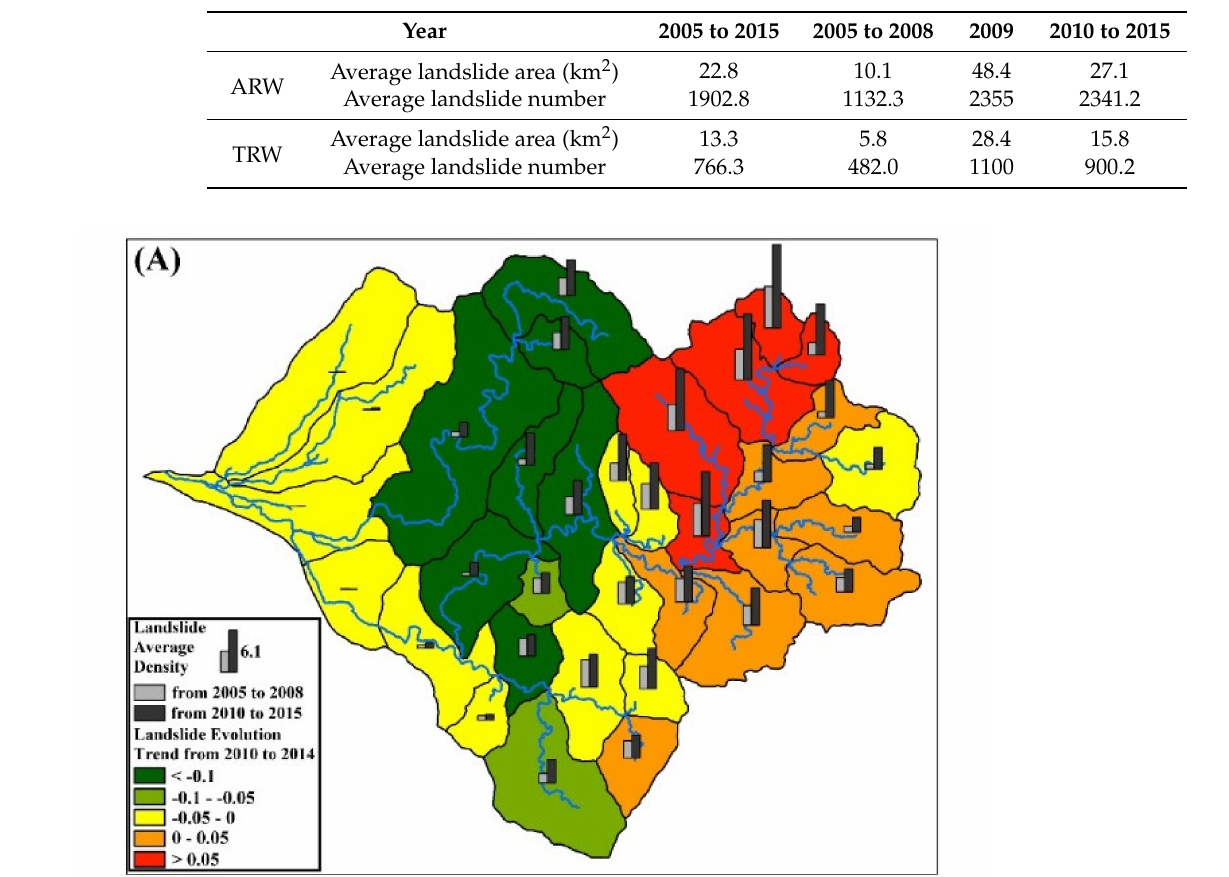
Table 3. The average area and number of landslides in the two watersheds.